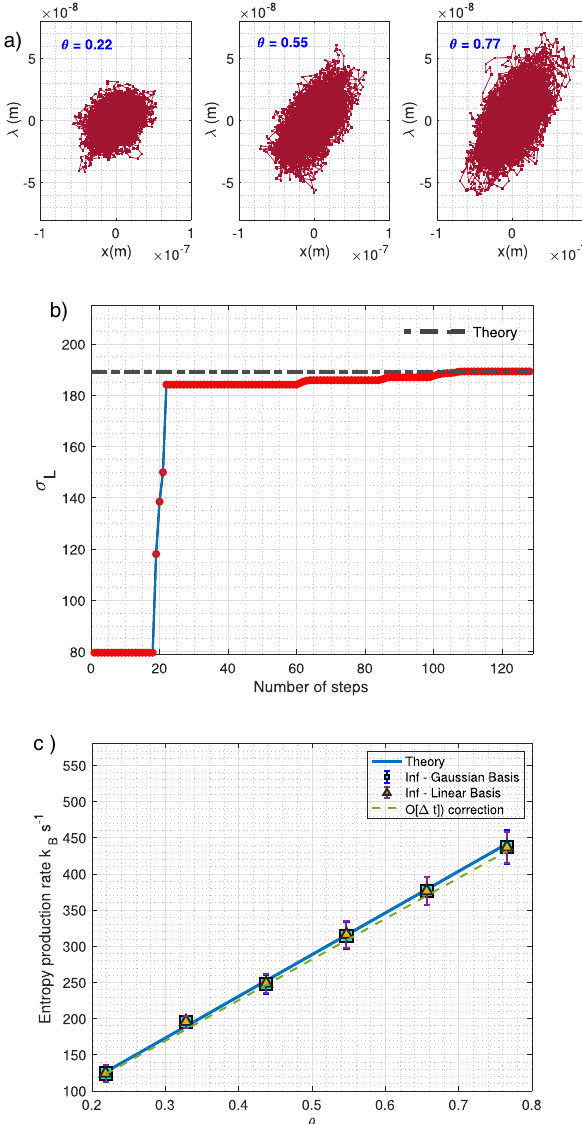
Fig. 1 The short-time inference scheme tested on numerical data. a Brownian trajectories of the Stochastic sliding parabola for different values of θ = A / D [ θ = 0.22, 0.55 and 0.77], where A is the amplitude of the noise in the Ornstein – Uhlenbeck process de fi ned in Eq. (10) and D is the room temperature diffusion constant. b The inferred entropy production rate ( σ L ) plotted against the number of steps in the optimization process for θ = 0.33 obtained using a sampling interval Δ t = 0.1 ms. The dashed line corresponds to the true entropy production rate. c Inferred entropy production as a function of the parameter θ . The blue line corresponds to the theoretical value of σ , Eq. (14). The squares correspond to the inferred values of σ using the inference scheme (Eq. (4)) in the Gaussian basis, and triangles correspond to inference using the linear basis. The green dashed line corresponds to the best estimate of σ that can be obtained using inference with a sampling interval Δ t = 0.0001 s, using Eq. (15). The error estimates are set by computing the standard deviation over the values obtained for an ensemble of 8 trajectories (see the “ Methods ” section). The parameters used in the simulation are as follows: relaxation time in the harmonic trap, τ = 0.0012 s, the relaxation time of the Ornstein – Uhlenbeck process τ 0 = 0.0025 s, the room temperature diffusion constant D = 1.645 × 10 − 13 m 2 s − 1 , and time-step used in the numerical